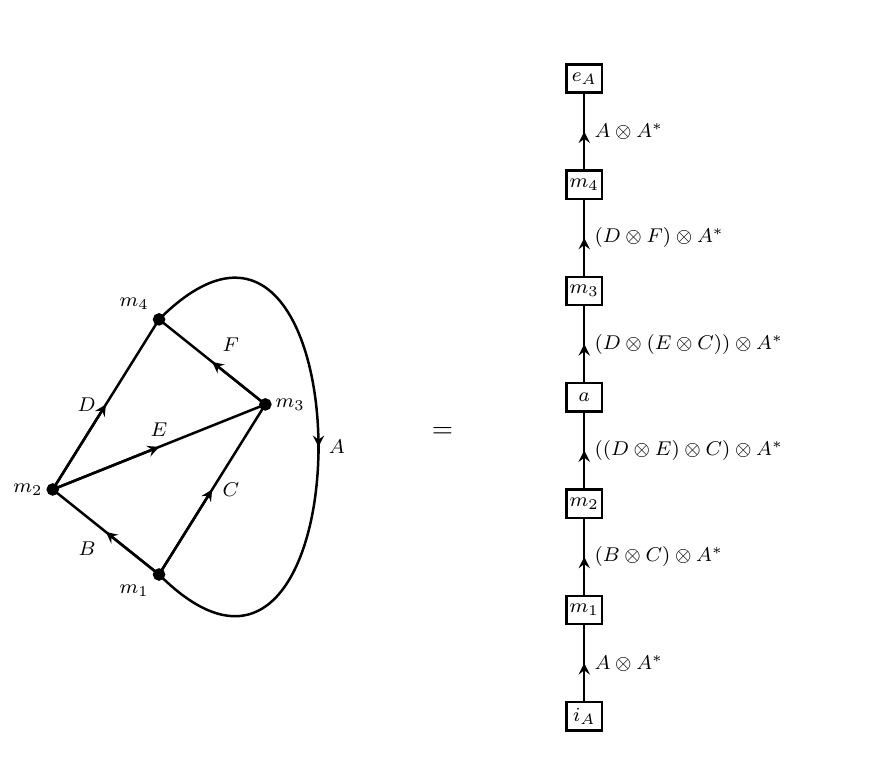
Figure 11 . The computation of a graph on the plane involves the listed morphisms. Here a denotes the associator tensored with identity morphism for A (cid:3) . The (cid:12)nal result is the partition function Z (cid:0) of the theory on a three-ball decorated by the graph (cid:0).